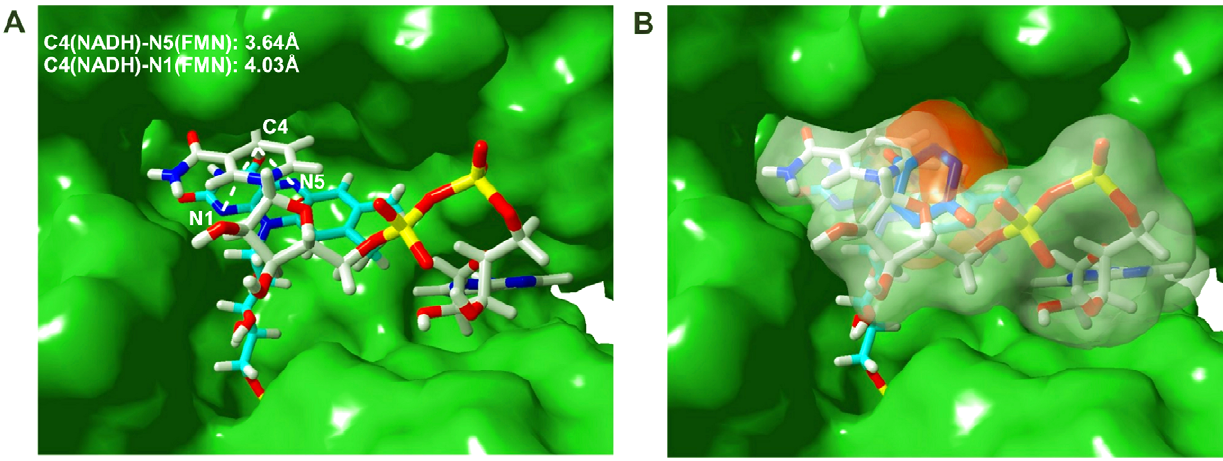
Figure 6. Substrate binding sites. A. NADH. View of the active site with NADH bound in the optimized position found by docking as described in the text. Green, molecular surface of holoWrbA calculated from the 2.05 A˚ crystal structure (PDB ID 3B6J) after removal of the FMN cofactor. Oxidized FMN is depicted as a skeletal model in atomic colors with cyan carbon, and docked NADH with white carbons for differentiation from FMN. Dashed lines represent the indicated distances in A˚ between nicotinamide C4 and each indicated electron acceptor site of FMN. B. Mutual exclusivity of NADH and BQ. Viewpoint of the binding cavity as in panel A but slightly zoomed out to better depict the steric environment of the full pocket. Translucent white indicates the molecular surface of NADH in the position identified by docking as in panel A; red indicates the molecular surface of BQ calculated from the 1.99 A˚ crystal structure of the BQ/WrbA complex (PDB ID 3B6K). The part of each substrate that is occluded by the other is represented by the overlap between the red and translucent white surfaces.